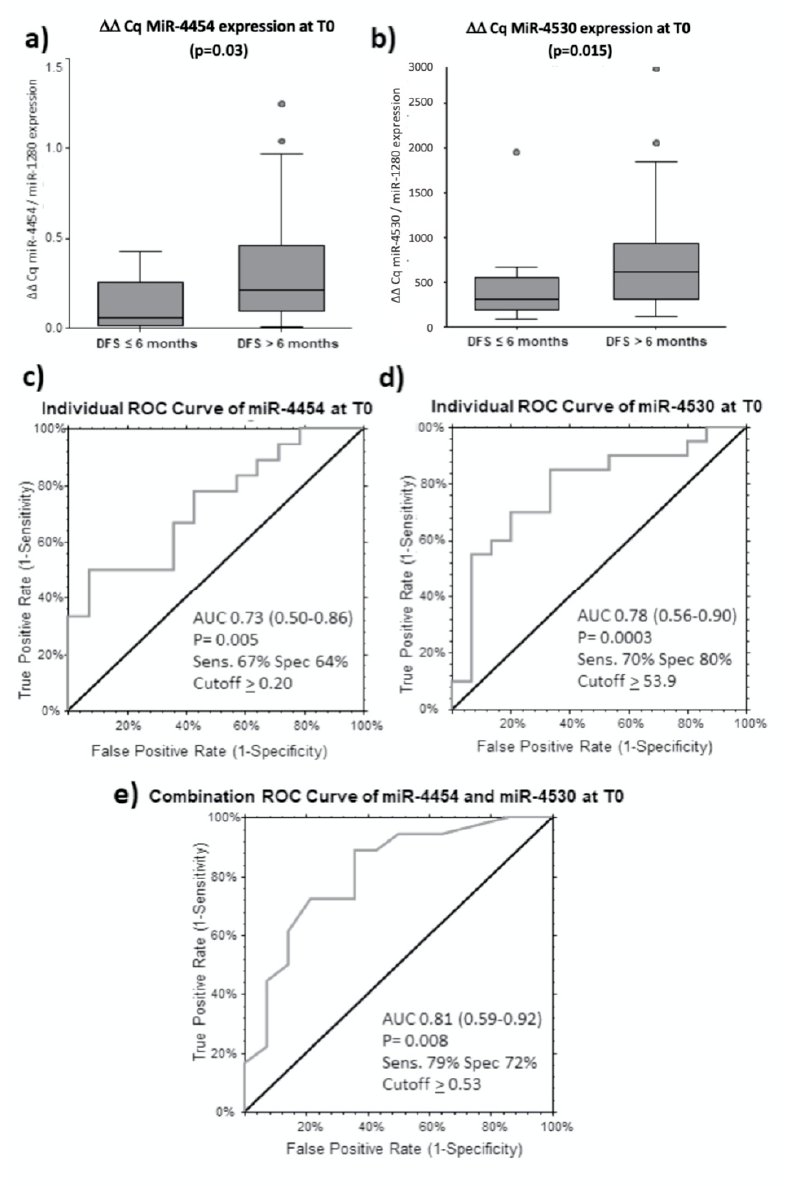
Figure 5. MiR-4454 and miR-4530 are predictors for longer disease-free survival (DFS) for curative Figure 5. MiR ‐ 4454 and miR ‐ 4530 are predictors for longer disease ‐ free survival (DFS) for curative treatments. Mean ∆∆ Cq expression of miR-4454 ( a ) and miR-4530 ( b ) in patients with DFS ≤ 6 months treatments. Mean  Cq expression of miR ‐ 4454 ( a ) and miR ‐ 4530 ( b ) in patients with DFS ≤ 6 months and DFS > 6 months at T0. ROC analysis of miR-4454 ( c ), miR-4530 ( d ) and in combination ( e and DFS > 6 months at T0. ROC analysis of miR ‐ 4454 ( c ), miR ‐ 4530 ( d ) and in combination ( e ).